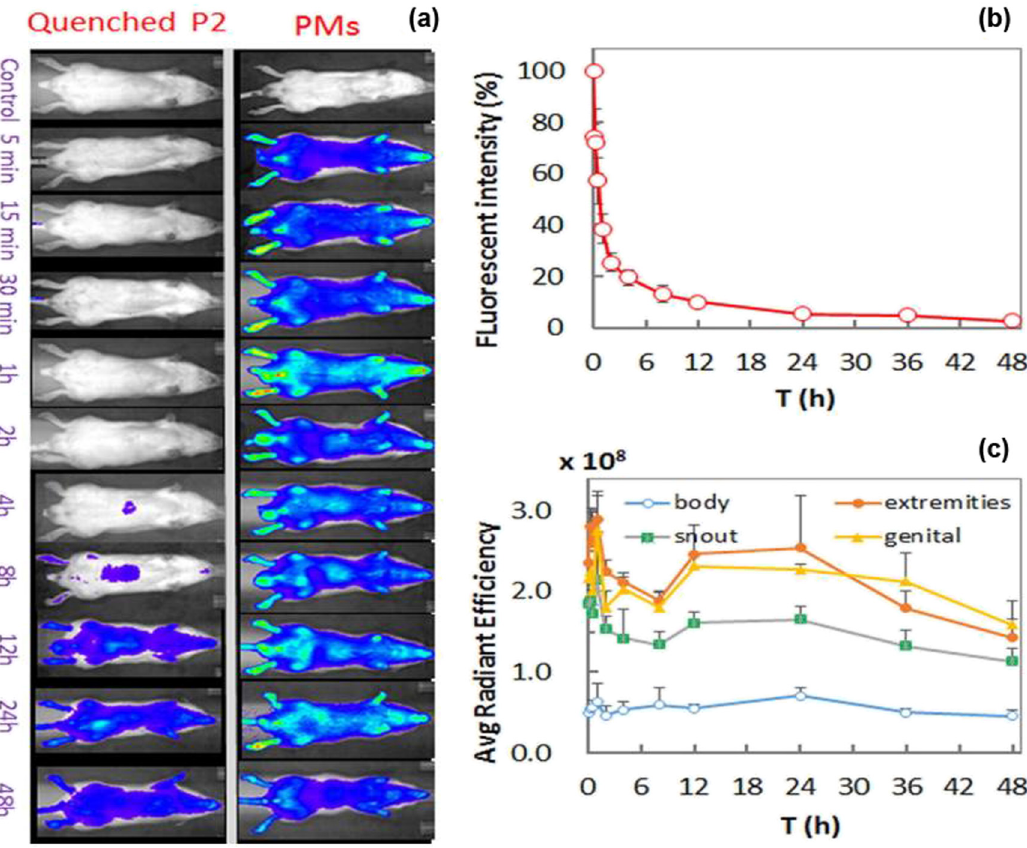
Figure 4: Live imaging of P2 - labelled PMs after i.v. administration to rats ( a ) , plasma pharmacokinetic pro fi le ( b ) , and fractionized quanti fi cation of fl uorescence of regions of interest as average radiant e ffi ciency [ p/s/cm 2 /sr ] / [ µW/cm 2 ] ( c ) [ 59 ]